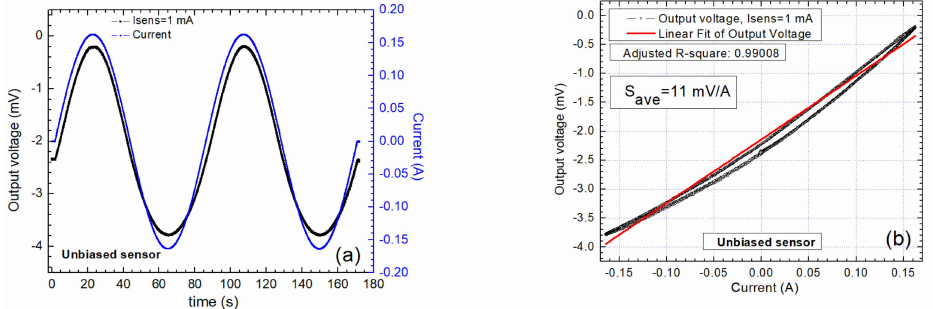
Figure 7. Output characteristics when the sensor AA003-02 is unbiased: ( a ) Comparison between the input current and the output voltage wave forms; ( b ) the output voltage as a function of the applied current through the current trace.